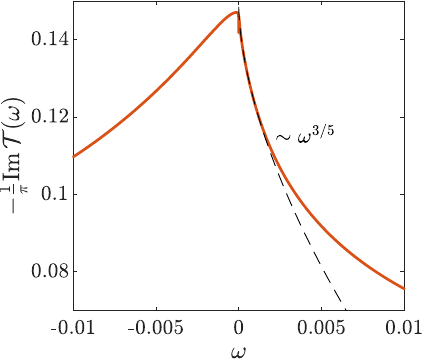
FIG. 5. Impurity spectral function, computed by FDM NRG [52], for ð J 0 ; K 0 ; I 0 Þ ¼ ð 0 ; 0 . 3 ; 0 Þ . For ω > 0 , the ω 3 = 5 behavior is consistent with a boundary perturbation given by H 0 ω < 0 , clear power law cannot be